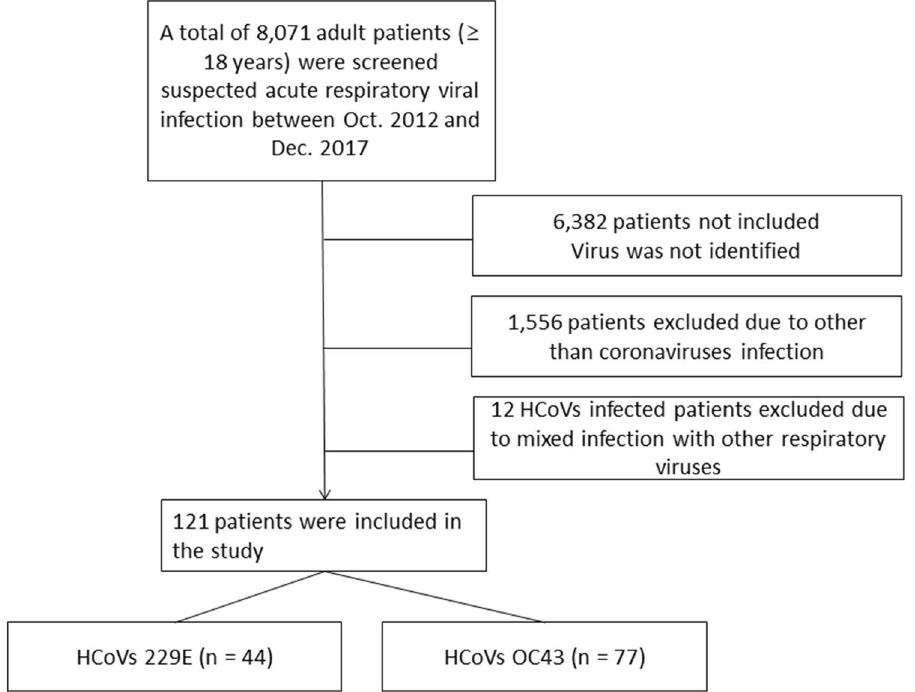
Figure 1. Flow chart showing the selection process of patients with human coronavirus